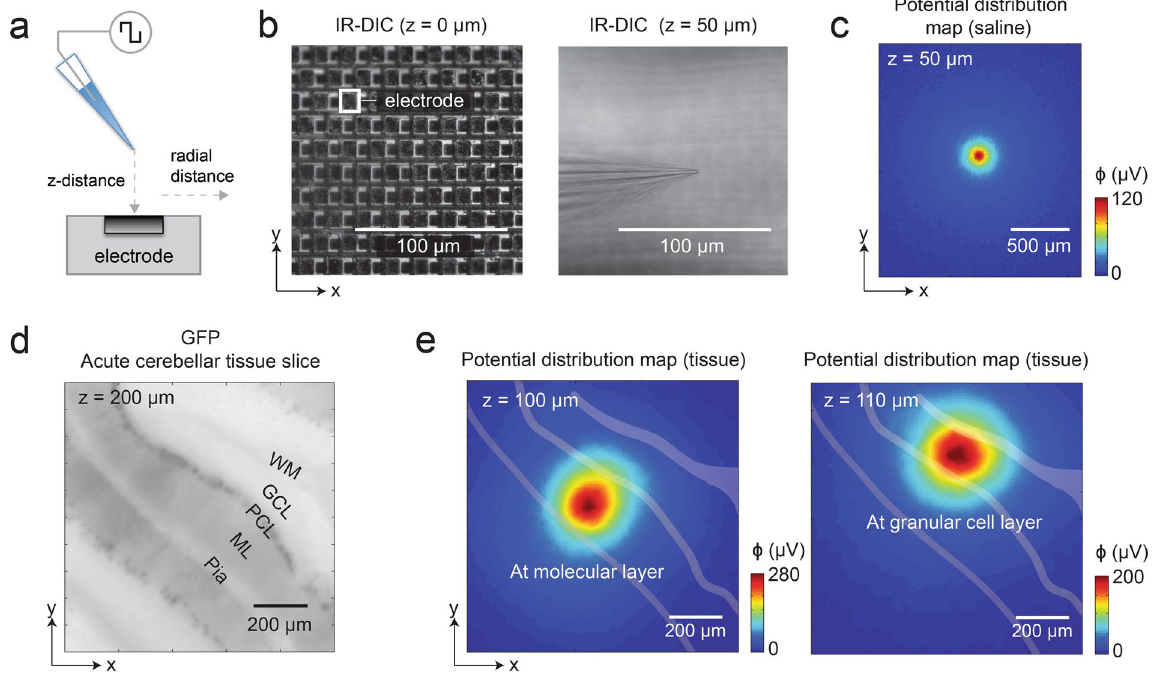
Figure 1. The x-y location of a micropipette can be electrically imaged using an HD-MEA. ( a ) A micropipette tip, stimulating with a current square wave (50 nA, 1 kHz), was used as a point-current source. The electrical potential landscape of the point source was measured in ( b , c ) saline and ( d , e ) in the presence of an acute brain slice of 200 μ m thickness by using an HD-MEA. ( b ) Microscopy images, using infrared differential interference contrast (IR-DIC), show the electrode array ( left panel ) and the micropipette tip ( right panel ). One electrode is highlighted; the electrode size is 10.2 μ m × 8.6 μ m, the electrodes are arranged in a hexagonal pattern, and the center-to-center distance between the electrodes is 17.8 μ m. The HD-MEA surface and the micropipette are at z = 0 and 50 μ m, respectively. ( c ) The map illustrates the measured potential spatial distribution of a stimulating micropipette, located at the center of the array at 50 μ m z-distance in saline as isotropic conductor medium. The voltage amplitude, detected at each electrode site, is color-coded (blue (0 μ V) to red (120 μ V)). ( d ) A 200- μ m thick-cerebellar slice atop the HD-MEA is imaged by fluorescence microscopy, using a green- fluorescent-protein (GFP) filter. The acute brain slice was obtained from a GAD67-GFP knock-in mouse, where the majority of the GABAergic neurons were GFP positive 36 . The cell bodies can be identified as dark spots in the Purkinje cell layer (PCL), and the dendritic arbors, shown in dark gray, indicate the molecular layer (ML). The other layers were determined according to the established cerebellar structure in literature: pia 39 , granular cell layer (GCL), and white matter (WM). ( e ) The potential spatial distribution maps similar to those in c were obtained by placing a stimulating micropipette at the ML ( left panel ) and at the GCL ( right panel ) of the acute cerebellar slice shown in (d)